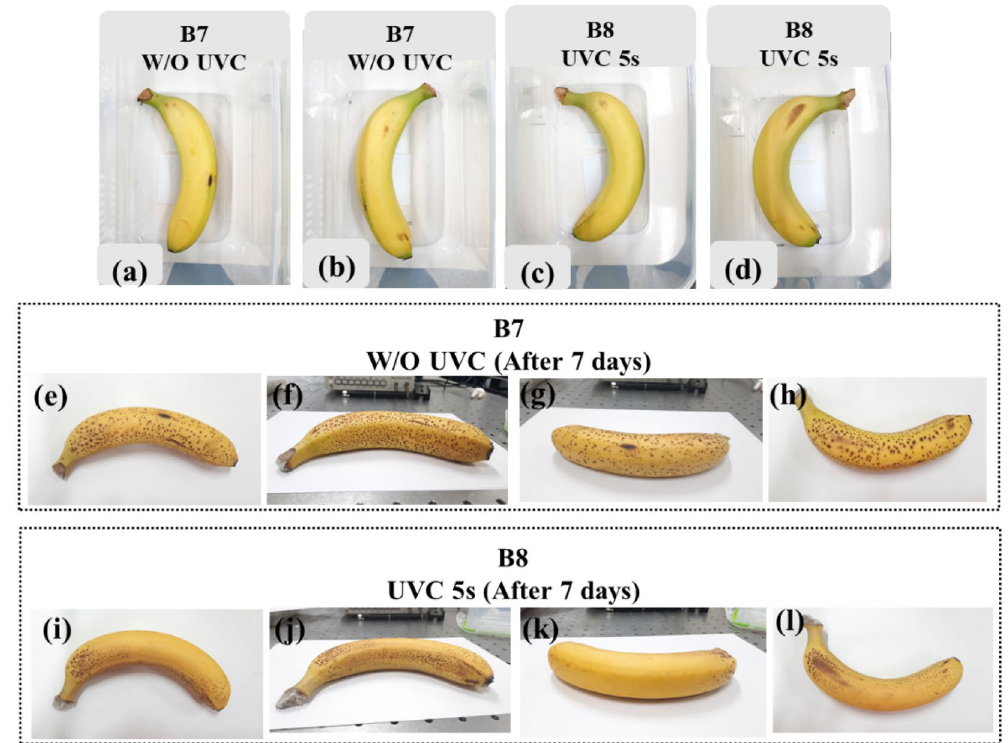
Figure 13. The photos of sample B7 without UVC treatment ( a ) top view, ( b ) bottom view; sample B8 was prepared for treatment with UVC light for 5 s observed from ( c ) top view, ( d ) bottom view; sample B7 after seven days observed ( e ) top view; ( f , g ) side view; and ( h ) bottom view; sample B8 after seven days observed from ( i ) top view; ( j , k ) side view; and ( l ) bottom